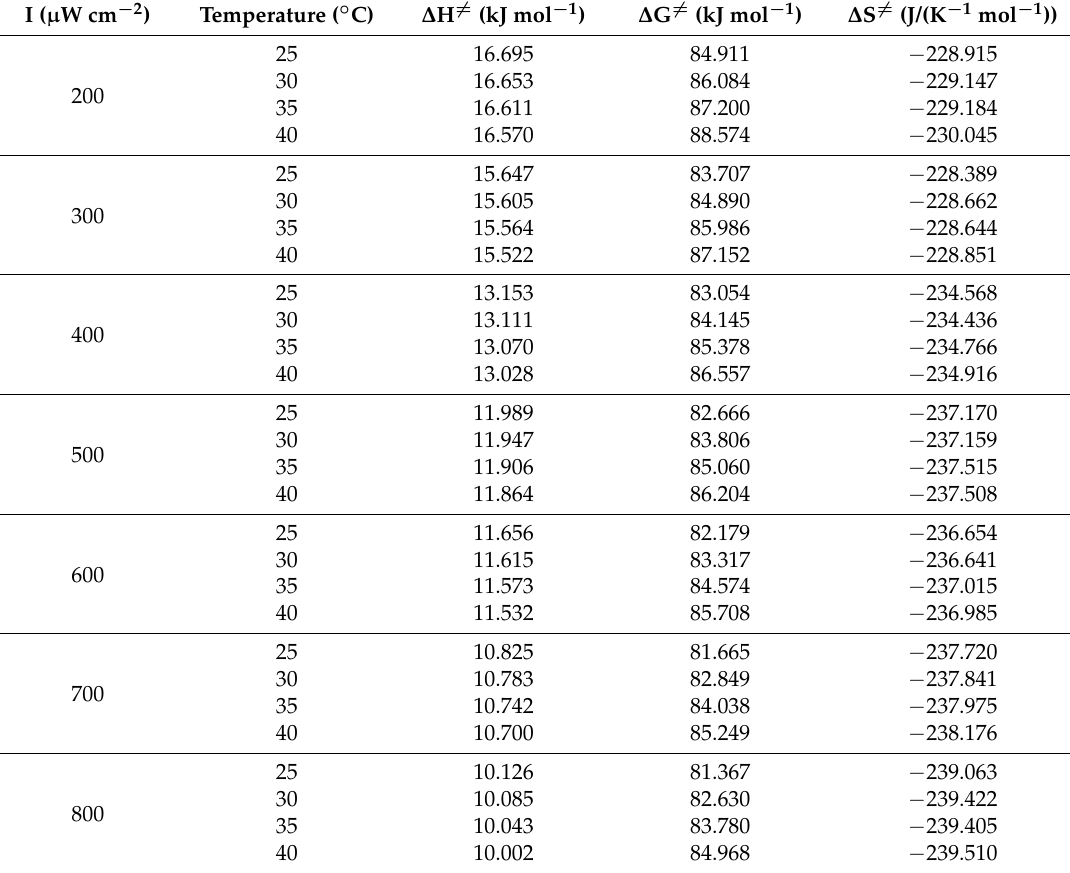
Table 4. Transition state parameters for the photo-oxidation of